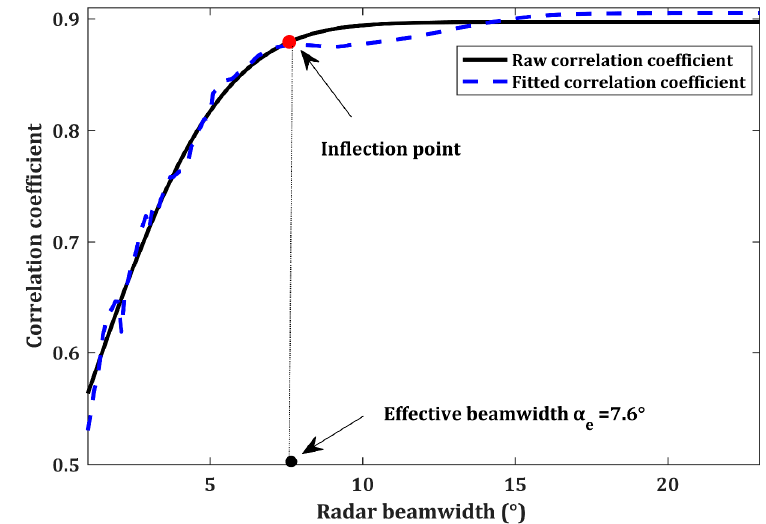
Figure 9. The distributions of correlation coefficients versus radar beamwidth for the 6700th measurement of Tomoradar. The inflection point is identified at a radar beamwidth of 7.6°.